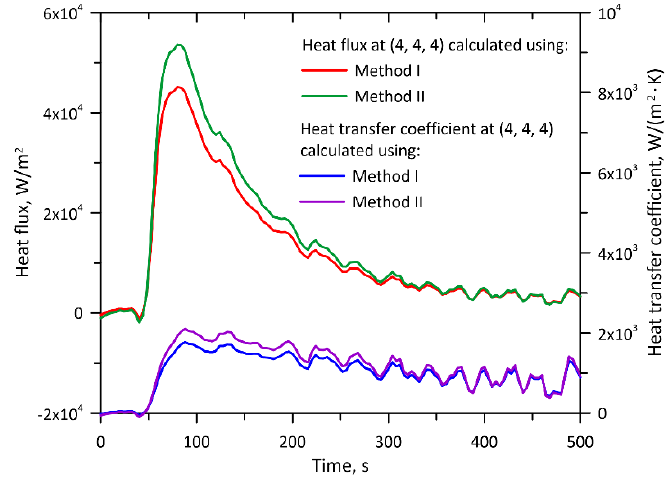
Figure 8. Time variations of the heat flux and heat transfer coefficient on the cooled surface when dividing the thickness of the plate into four control volumes.